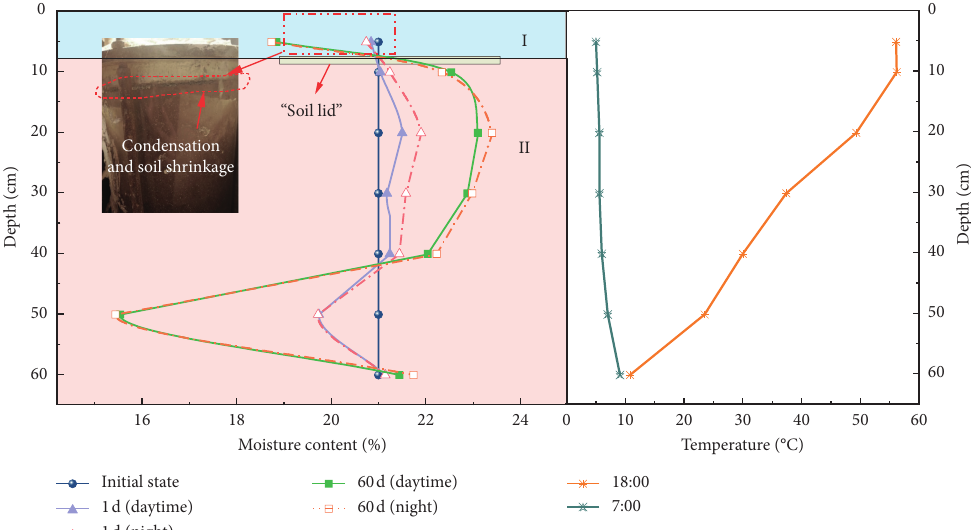
Figure 9: Moisture content distribution along the depth of the soil column (with a